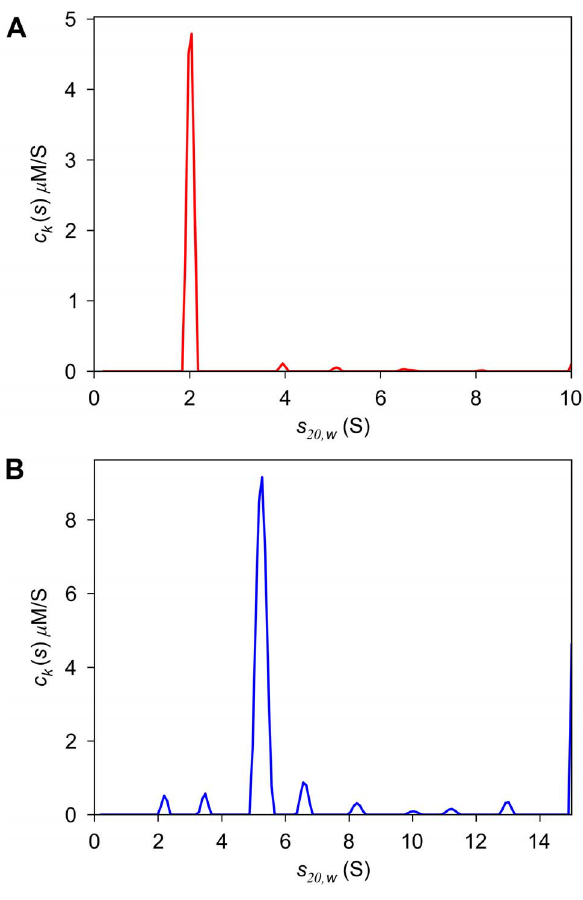
Figure 3. Analysis of the individual samples: c k ( s ) distributions from the MSSV analysis of SV data of Tp34 alone (A) and bLF alone (B).